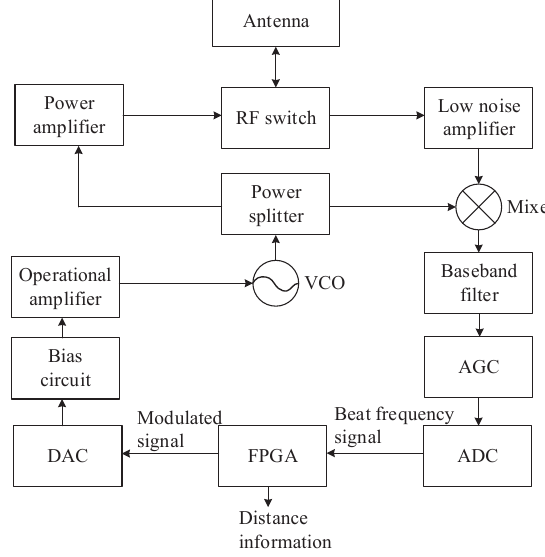
Figure 7. Block diagram of the frequency-modulated continuous wave (FMCW) ranging